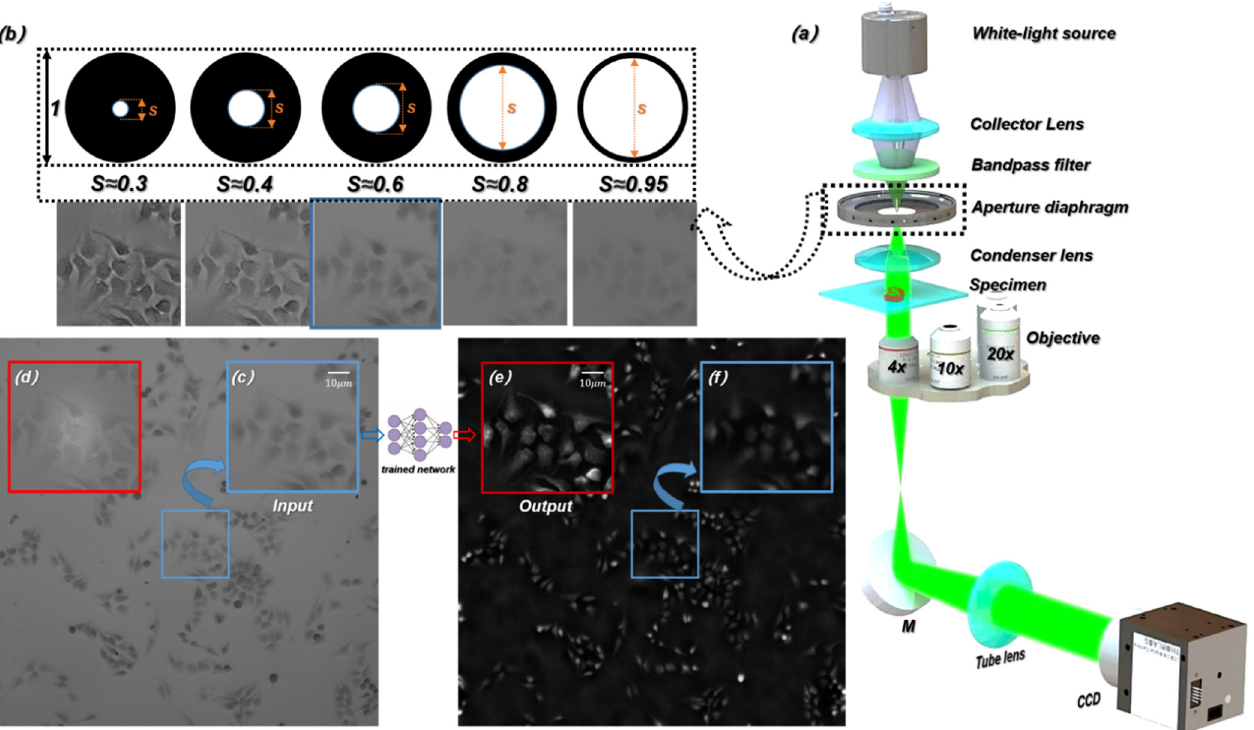
Figure 1. Experimental setup and acquisition process of the original images. ( a ) Imaging hardware setup. ( b ) Microscopic images obtained under a different aperture diaphragm. ( c ) The LR microscopic image captured directly in the experiment. ( d ) The HR microscopic image captured directly in the experiment. ( e ) The reconstructed HR quantitative phase image by TIE. ( f ) The reconstructed LR quantitative phase image by TIE.